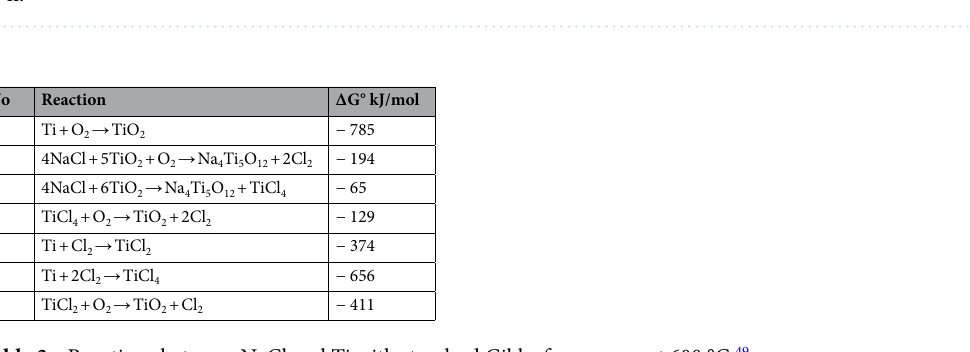
Table 3. Reactions between NaCl and Ti with standard Gibbs free energy at 600 °C 49 .